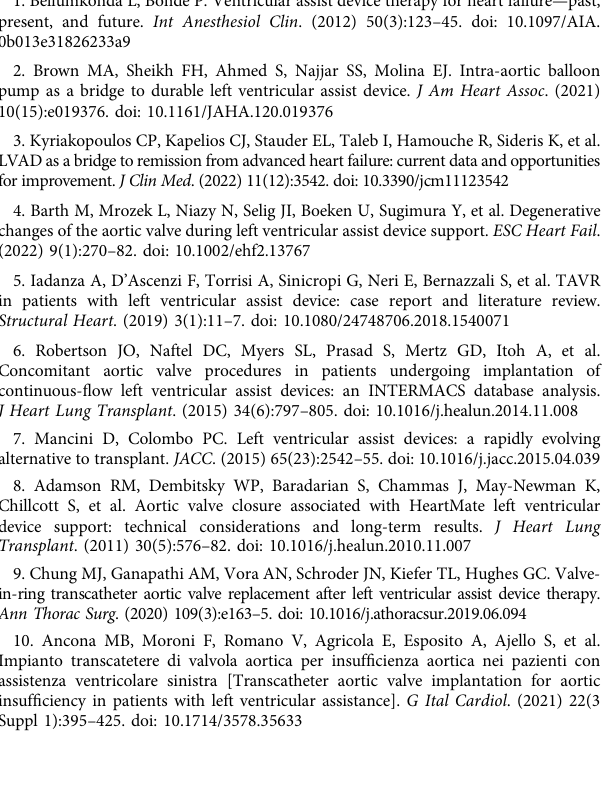
SUPPLEMENTARY FIGURE 1 Annulus (A) and Left (B) ventricular out fl ow tract measurement by multidetector row computed tomography. The resulting annular plane is seen. SUPPLEMENTARY FIGURE 2 The heights of right (A) and left (B) coronary artery from basal plane measurement by multidetector row computed tomography. SUPPLEMENTARY FIGURE 3 Pictorial representation of Ethibond sutures with fl exible ring[11]. SUPPLEMENTARY FIGURE 4 A- Transcatheter heart valve lea fl ets (yellow arrow); Color Doppler with no signs of PVL; B- Annular ring (yellow arrow); Transcatheter heart valve (green arrow); Left ventricular assist device (blue